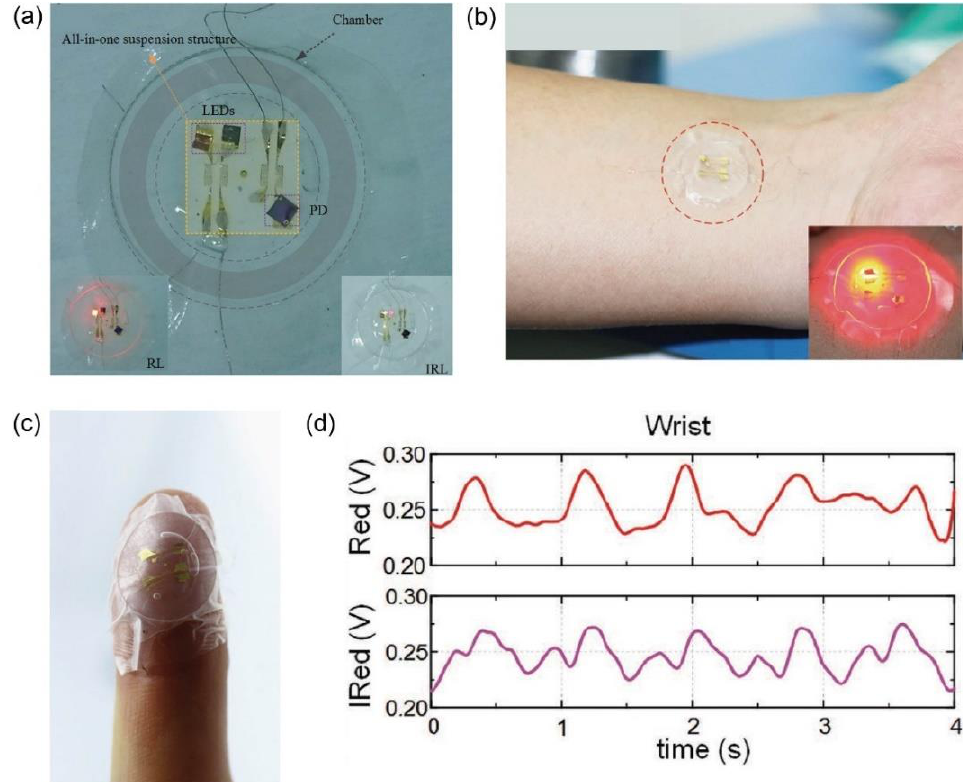
Figure 6. ( a ) Image of the PPG device based on GaAs and silicone material, including two LEDs and a photodetector. Inset, the left light is red (620 nm) and the right light is infrared (850 nm). ( b ) The image of device attached to the wrist and ( c ) The inset shows the stable operation of the device on fingertip. ( d ) The measured PPG signal while the subject’s forearm moves slowly is applicable for SpO 2 calculation. Adapted with permission from [32], Wiley, 2017.